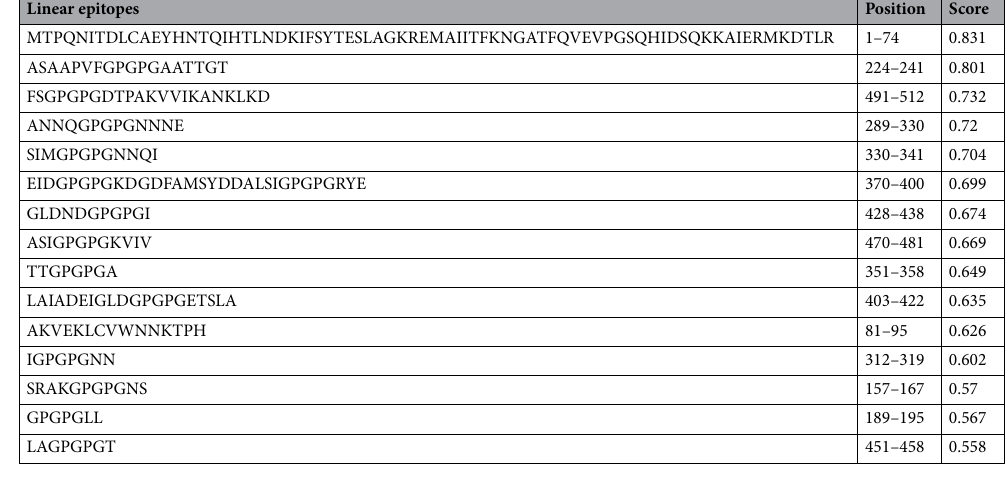
Table 3. Linear/continuous B cell epitopes as predicted by ElliPro server.